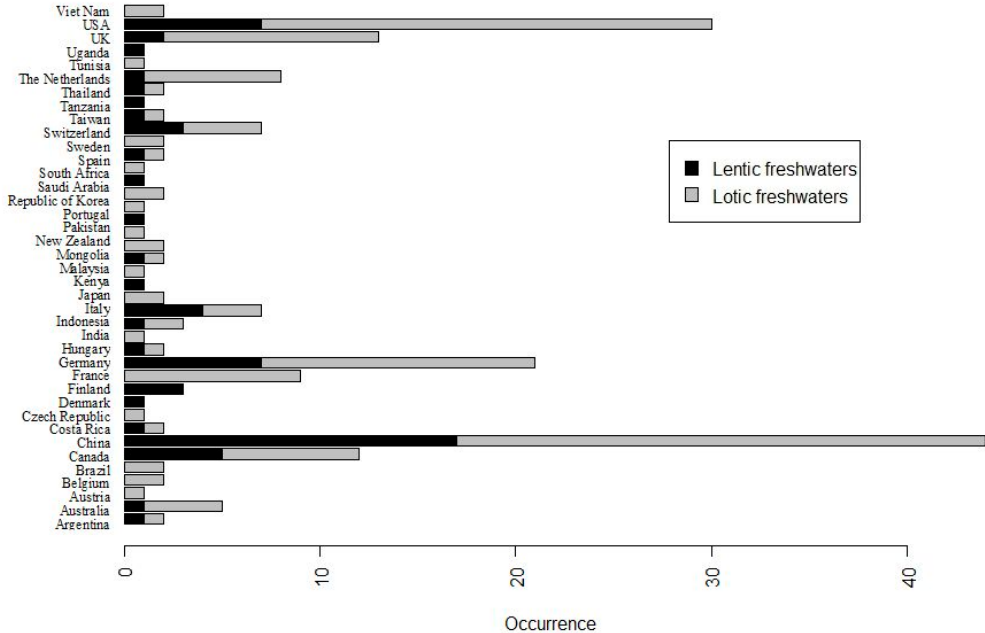
Figure 3. Affiliate countries of researchers studying freshwater microplastics.